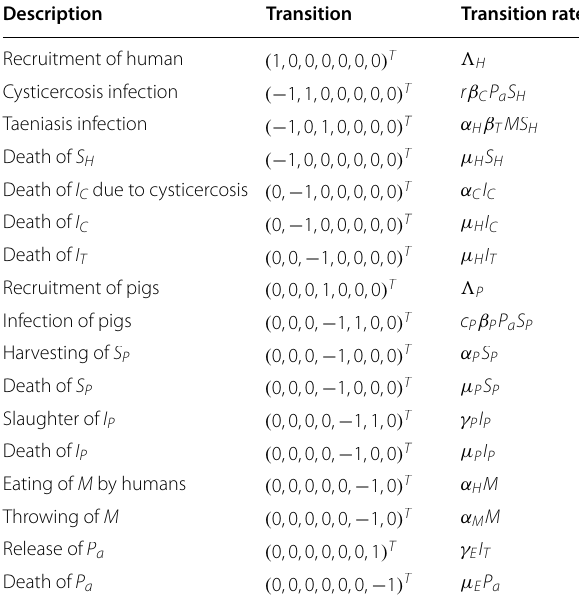
Table 3 State transitions and rates for CTMC